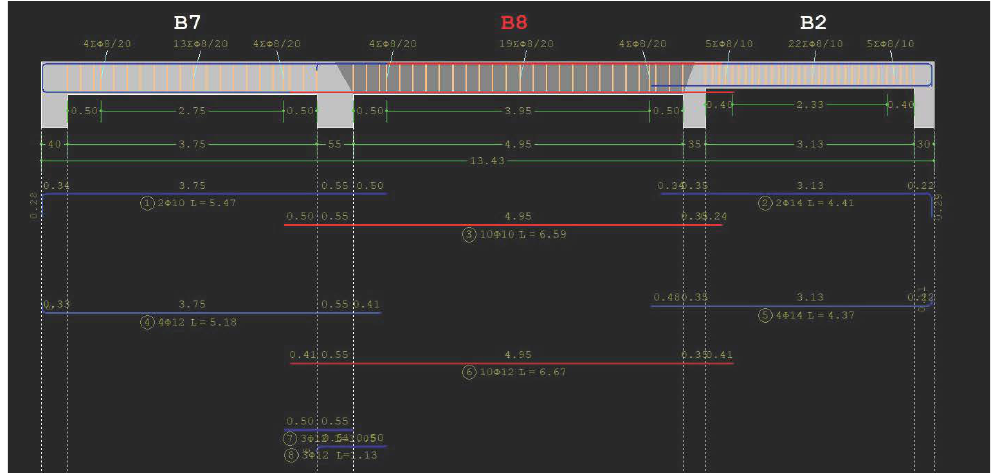
Figure 6. A typical detailing of reinforcement on the upper floor of Building